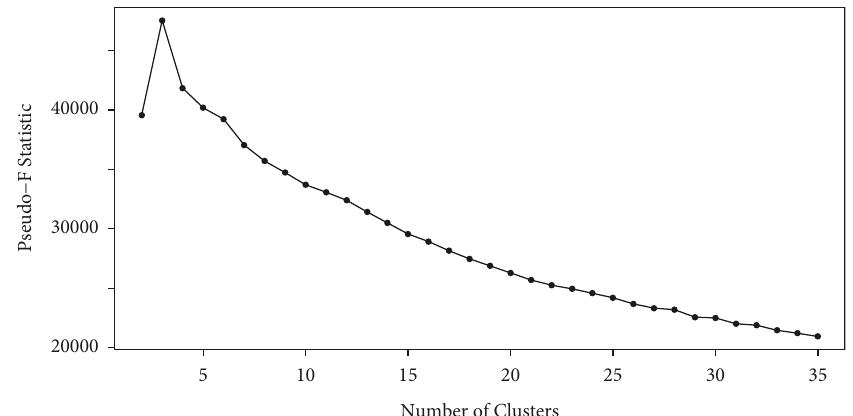
Figure 5: Pseudo- F statistic for clustering with different number of clusters ( k ).